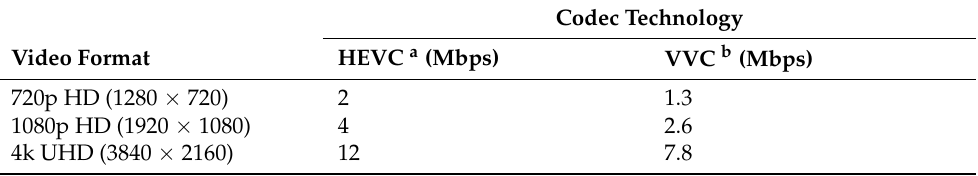
Table 3. Data rate requirements for HD and UHD video considering various codec technologies